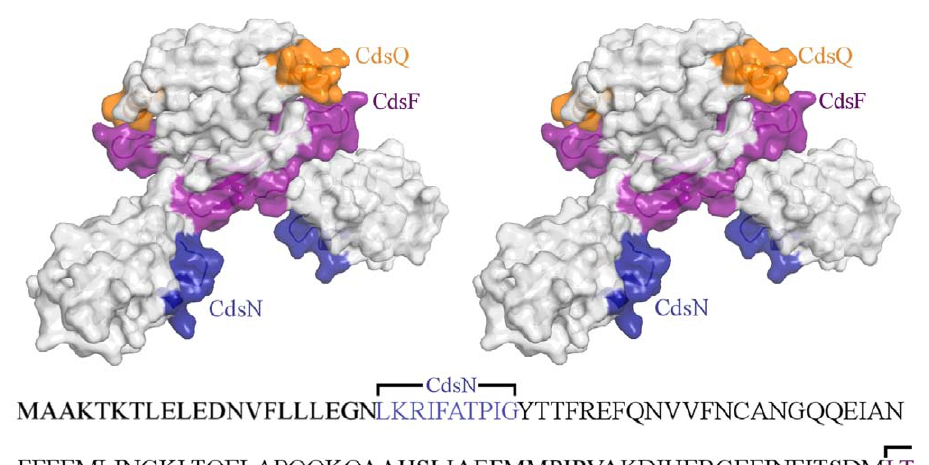
Figure 8. Pepscan mapping of the Cpn0803 binding regions shown in stereo. A. Pepscan epitope mapping against a Cpn0803 peptide library was performed to determine the residues of Cpn0803 responsible for mediating its interactions with CdsN, CdsF and CdsQ. Recombinant CdsN, CdsF and CdsQ was reacted against the Cpn0803 peptide library and monitored for the corresponding interacting regions. The corresponding surfaces are color-coded as follows: CdsN in blue (residues 22–26), CdsF in purple (residues 109–128), and CdsQ in orange (residues 153–161).